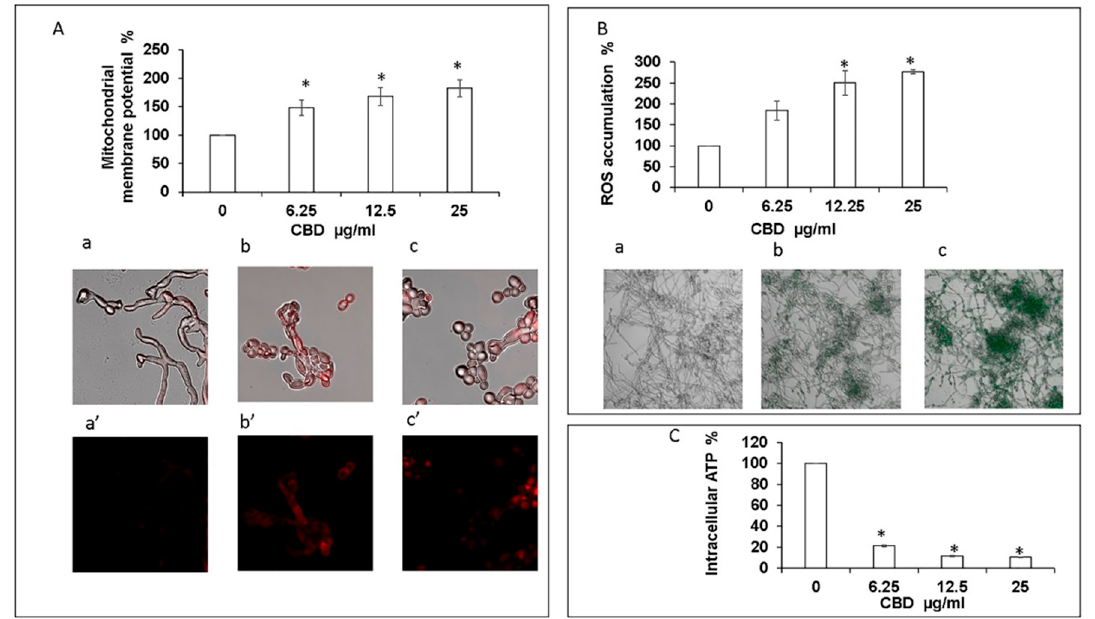
Figure 5. Assessment of mitochondrial function and ROS production. ( A ). Effect of CBD on C. albicans mitochondrial membrane potential (MMP) as determined by DiOC2(3). * Significantly higher than the untreated control ( p < 0.05); Mito Tracker Red-stained biofilms were observed by CLSM. Phase-contrast and Mito Tracker Red stain merged images (a–c), or Mito Tracker Red stain (a’–c’) of untreated control (a,a’); biofilms treated with 12.5 µ g/mL (b,b’) or 25 µ g/mL (c,c’) of CBD. Magnification 600 × . ( B ). Effect of CBD on ROS accumulation. C. albicans biofilms formed in the absence or presence of CBD were loaded with DCFHDA and the relative fluorescence intensities (RFI) of the biofilms were measured in a plate reader. The RFI values were normalized to the amount of metabolically active cells in biofilms assessed by MTT assay. * Significantly higher than the untreated control ( p < 0.05). Fluorescence images of untreated control (a), biofilm treated with 6.25 µ g/mL (b) and 25 µ g/mL (c) of CBD were captured by CLSM. Magnification 200 × . ( C ). Effect of CBD on intracellular ATP levels. C. albicans biofilms formed in the absence or presence of CBD were analyzed for ATP content using the BacTiter-Glo reagent. * Significantly lower than the untreated control ( p <